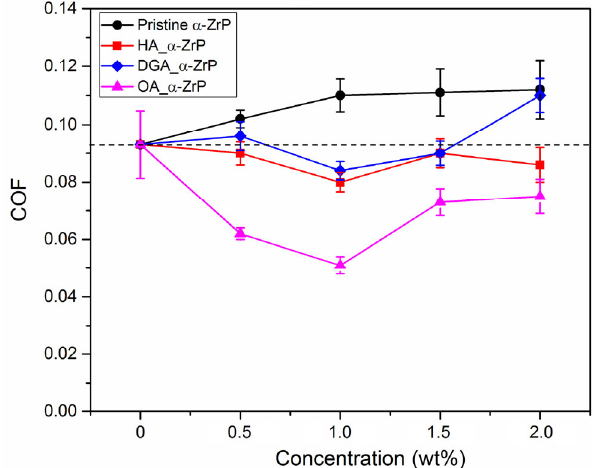
Fig. 8 Coefficient of friction as a function of concentration for pristine  -ZrP, HA_  -ZrP, DGA_  -ZrP, and OA_  -ZrP nanosheets in mineral oil. The dotted line represents the value for the pure mineral oil.